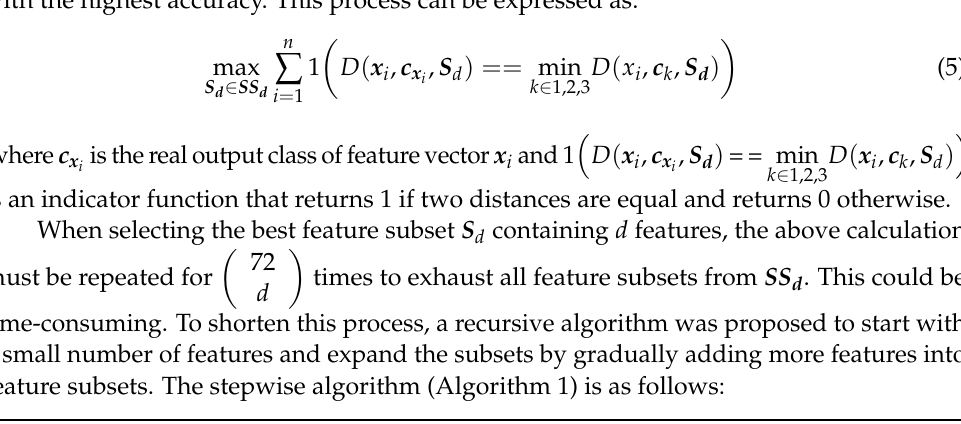
Algorithm 1: Recursive Feature